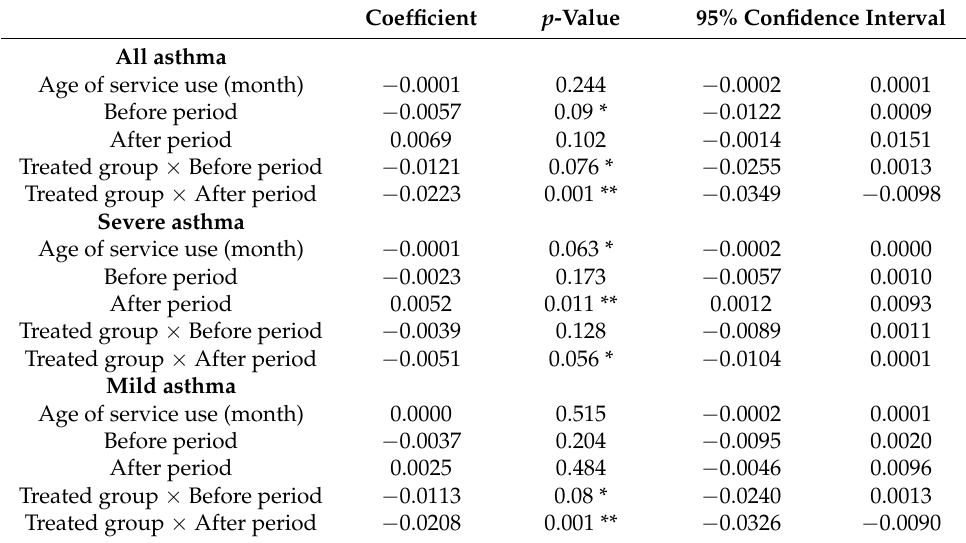
Table A4. Predicted coefficient of the interaction term of treated groups and period without using propensity score weighting.